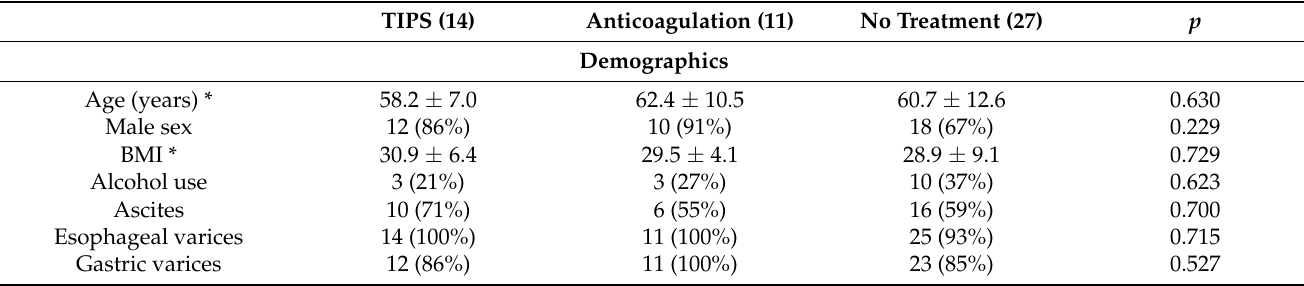
Table 1. Baseline characteristics of the study cohort.